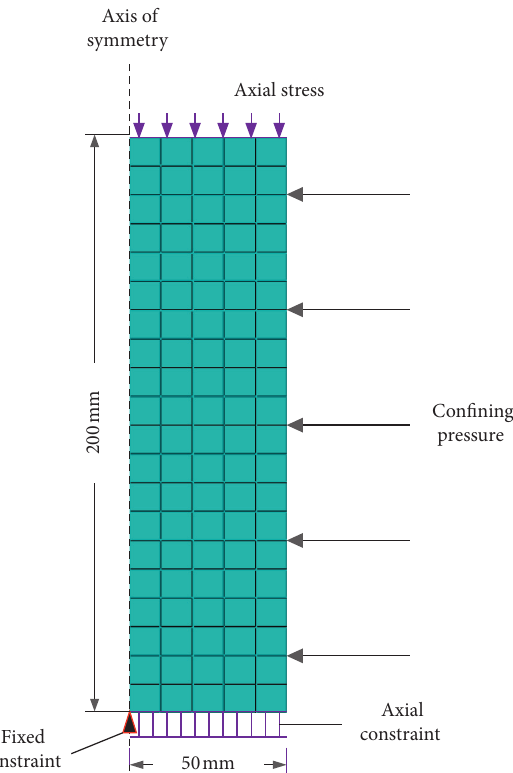
Figure 10: Finite element calculation model.